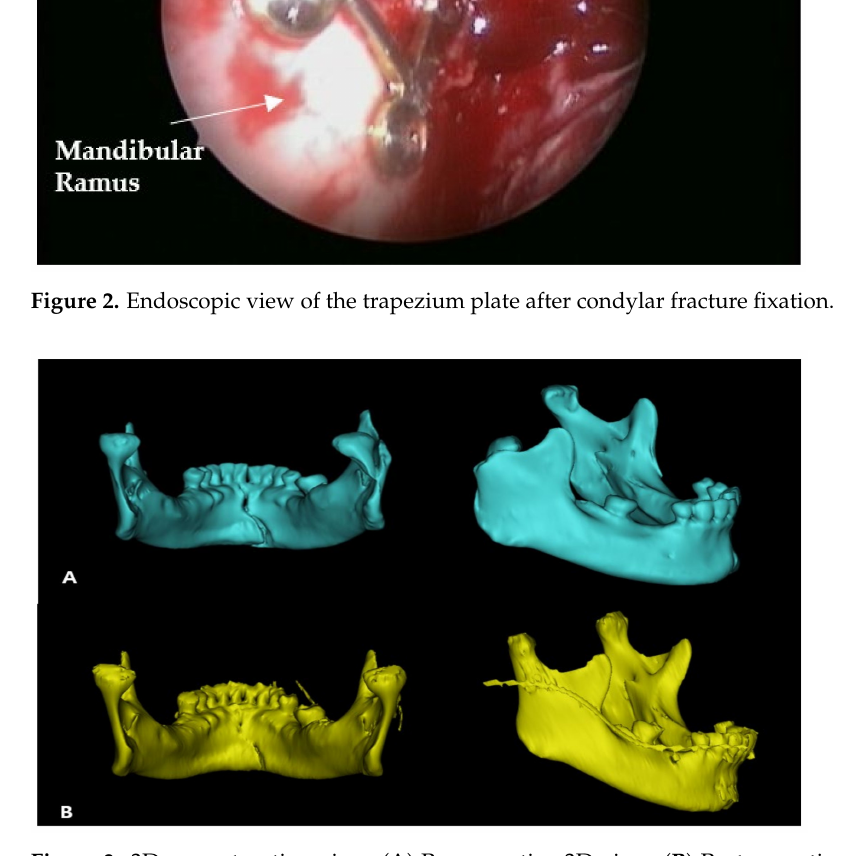
Figure 3. 3D reconstruction view. ( A ) Pre-operative 3D view. ( B ) Post-operative 3D view. Using Mimics, an image of the condylar head collapsing inward before surgery was reproduced, and it was confirmed that the condylar head was repositioned after